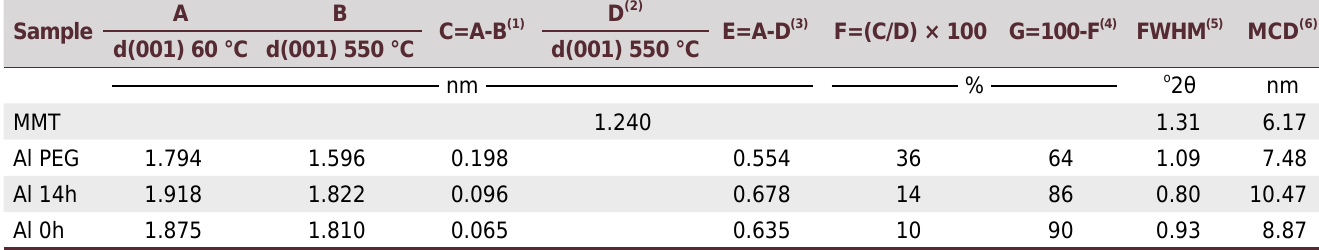
(1) C: reduction of the basal distance of the pillared minerals between the heating at 60 and 550 °C. (2) D: basal distance of MMT K + + 550 °C. (3) E: reduction of the basal distance of pillared minerals in relation to MMT K + + 550 °C. (4) G: the degree of occupation of the Al-hydroxy.